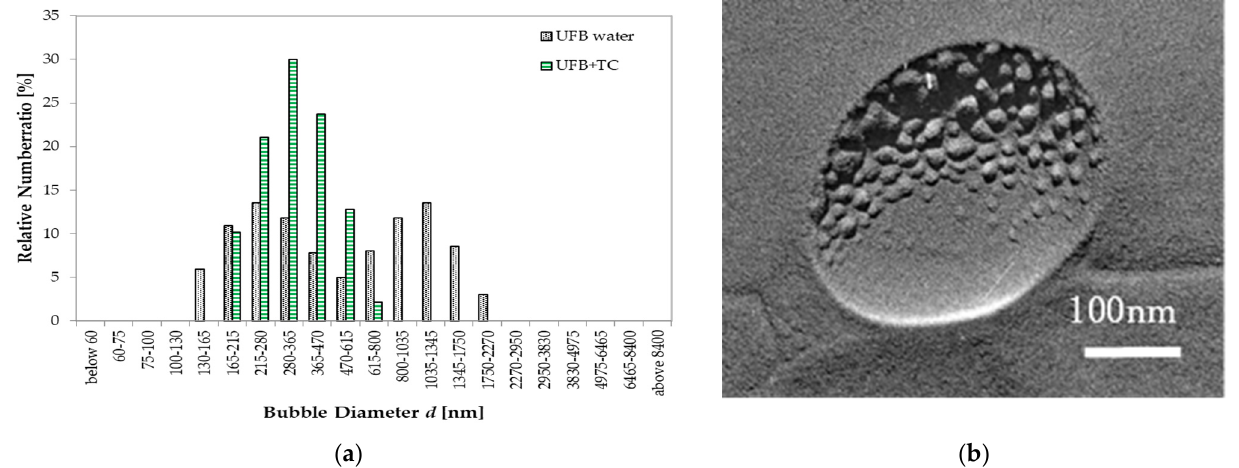
Figure 10. UFB sizes with TC. ( a ) Size distributions in pure water (gray solid) and in water with TC of 0.1 wt% (green hatched). Ordinate scale is the fraction of UFBs per listed size range (both distributions add up to 100%). ( b ) TEM image of freeze-fracture replica of a UFB in the TC solution.